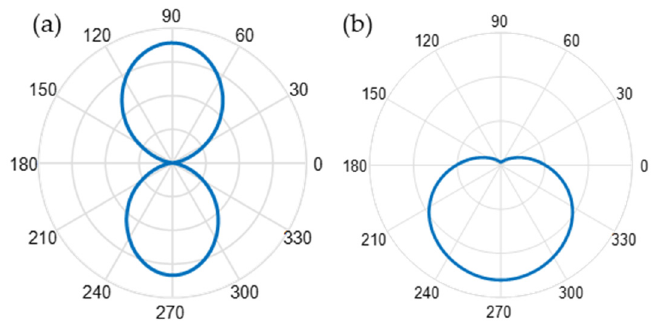
Figure 8. Cross-section of the far-field radiation pattern of an x -oriented dipole when coupled to ( a ) a reference structure including a glass surface and ( b ) resonant cylindrical structure featuring an overlap between electric and magnetic dipole resonances. Table 1. Collection efficiency enhancement of an optical fiber with NA = 0.5. The dipole is located at the center 7 nm above the structure. X , Y , and Z orientations of the dipole are considered. Array of 20 nm Dipole Orientation Array of Cylinders Array of Trimers Gap Dimers X -oriented dipole